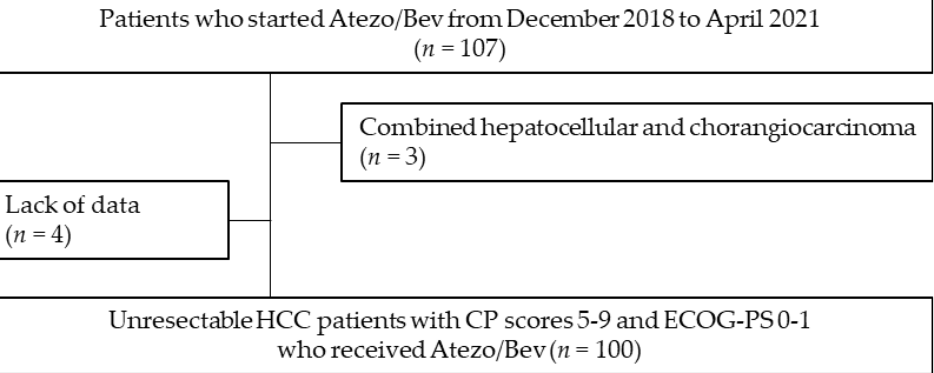
Figure 1. Flowchart of the study design. Abbreviations: Atezo/Bev, atezolizumab plus bevacizumab therapy; CP, Child – Pugh; ECOG-PS, Eastern Cooperative Oncology Group performance status; HCC, hepatocellular carcinoma. Table 1. Baseline characteristics of patients ( n =